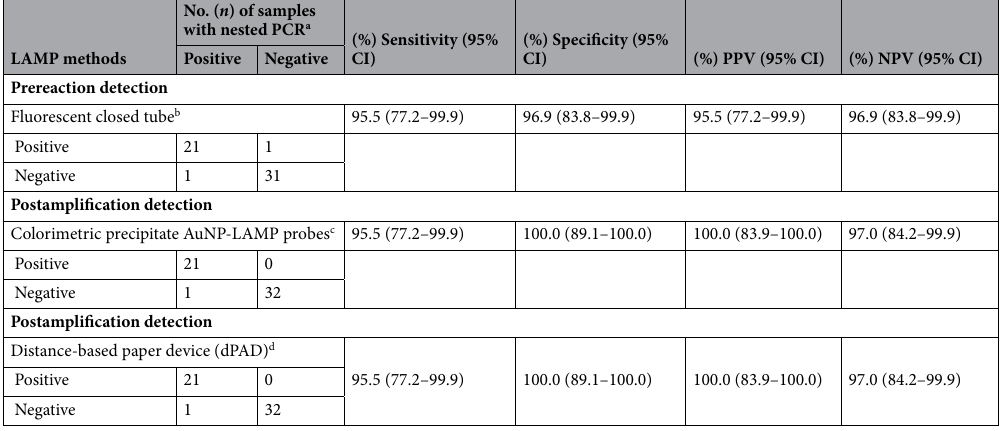
Table 1. Sensitivity and specificity of prereaction detection using nonspecific SYBR safe indicator and postamplification detection using specific AuNP-LAMP probes and quantitative dPAD in single LAMP assay to detect Leishmania DNA among patients with asymptomatic leishmaniasis. a Total number of positive results was based on nested PCR (reference standard method). b SYBR safe initially mixed in the reaction before salt induction of postamplification detection was used as a fluorescent indicator for qualitative screening. c Gold nanoparticle was used as a color and precipitate indicator for specific evaluation. d Measurement of fluorescent migratory distance was used to semi-quantify the LAMP amplicons.